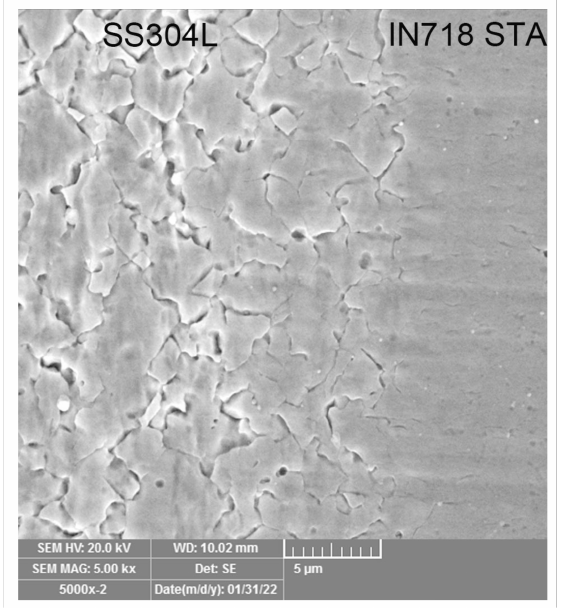
Figure 11. SEM micrograph of the SS304L/IN718 STA weldment at the interface